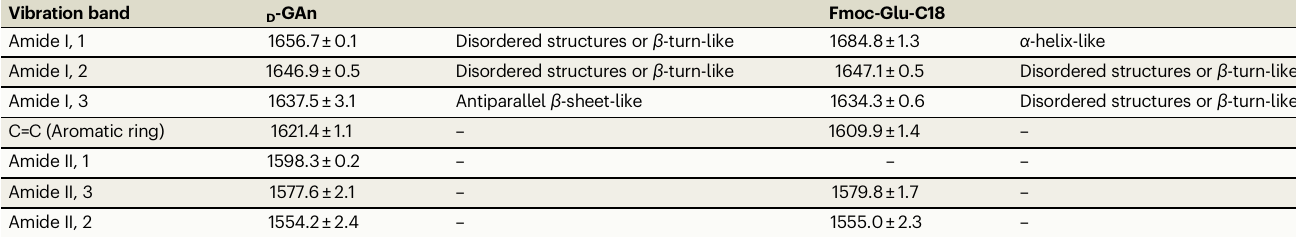
Table 1 | Peak and β - sheet-like or α -helix-like assignment of amide SFG spectral of D -GAn and